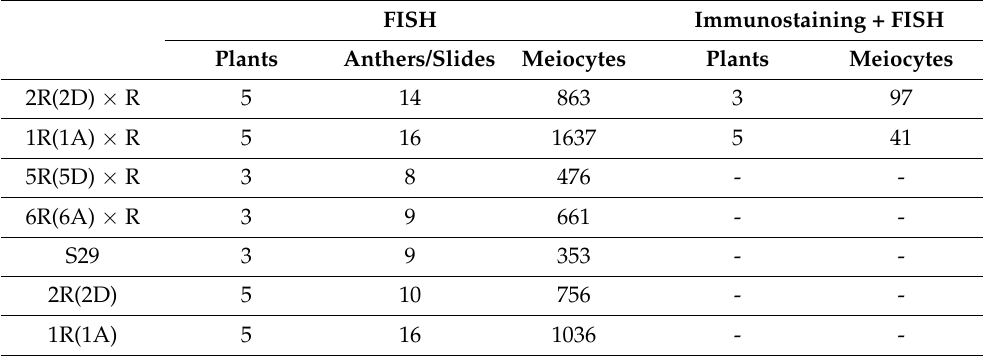
Table 3. Materials analysed in the